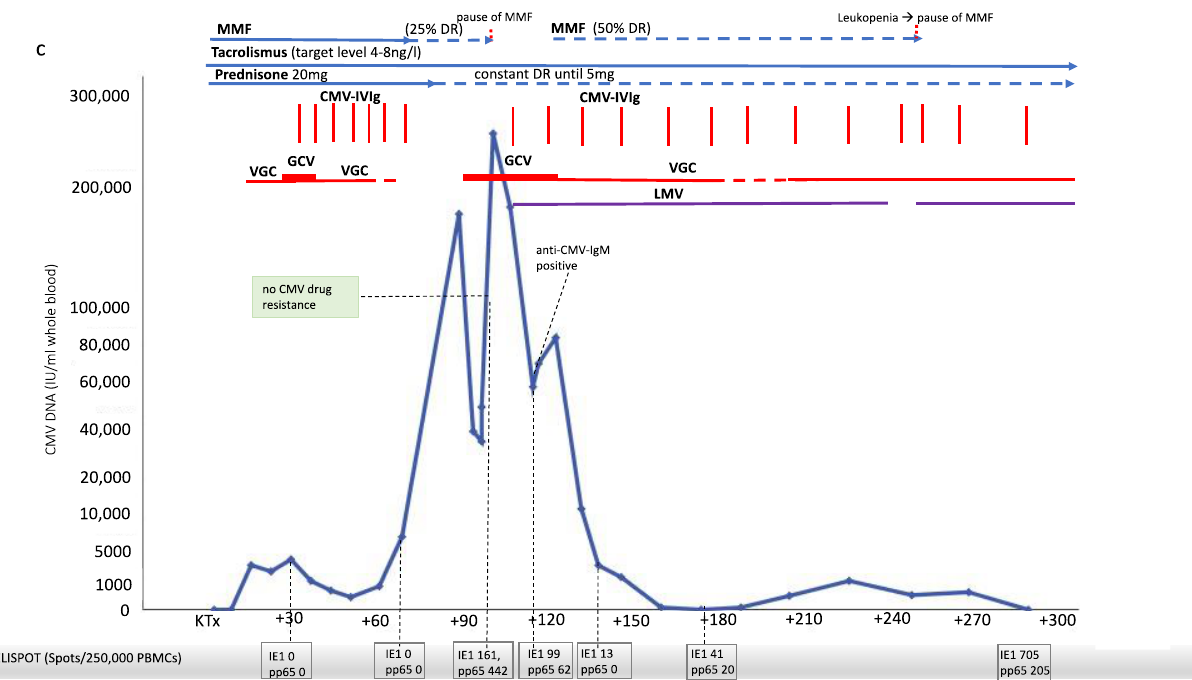
Figure 1. Post-transplantation dynamics of CMV viremia, immunosuppressive therapy, cellular immunity against CMV (T-SPOT.CMV Elispot assay by Oxford Immunotec), antiviral strategies and clinical course in three patients after transplantation. X -axis: days after transplantation. ( a ) Case 1. Allogeneic–hematopoietic stem cell transplantation (allo-HSCT) recipient (HLA 10/10 MUD; CMV serostatus D+/R+; ABO compatible). ( b ) Case 2. Kidney transplantation (KTx) from deceased donor (HLA MM A-1, B-2, DR-2; CMV serostatus D+/ R− ; AB0 compatible). ( c ) Case 3. Kidney transplantation from living donor (HLA MM A-0, B-1, DR-1; CMV serostatus D − / R− ; ABO compatible). Abbreviations: ATG, Anti-Thymocyte Globulin; DR, dose reduction; GCV, ganciclovir; CMV-IVIg, CMV-intravenous immunoglobulin; IE1, immediate-early 1; LMV, letermovir; MMF, mycophenolate mofetil; pp65, phosphoprotein 65; VGC, valganciclovir CMV-DNA was detected from whole blood using GeneProof CMV PCR Kit (Medac GmbH, Wedel, Germany). § Anti-viral drug resistance testing against VGC/GCV, FOS, CDV, and LMV was performed by amplification and sequencing of UL-97, UL-54, and UL-56. Interpretation was based on the bioinformatic tool MRA (“mutation resistance analyzer”) developed by the Institute of Virology of the University Hospital of Ulm, Germany (https://www.informatik.uni-ulm.de/ni/mitarbeiter/HKestler/mra/app/index.php?plugin=contact, accessed on 29 July 2021). IFN- γ producing T-cells (CD4+ and CD8+) reactive against CMV IE-1 and pp65 antigens were measured by the T-SPOT.CMV (Oxford Immunotec, Milton, UK ), according to the manufacturer’s instructions.